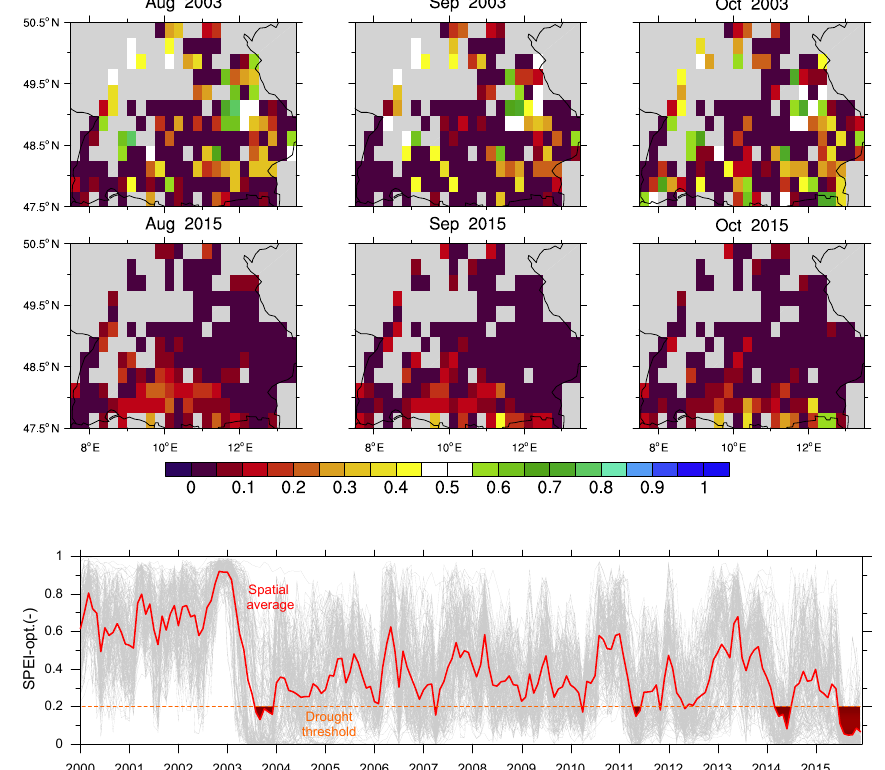
Figure 6. The reconstructed groundwater drought (SGI) based on the SPEI with spatially varying (optimal) accumulation periods during the months of August, September, and October for the 2003 and 2015 drought events over the south Germany study domain. The monthly time series of the optimally accumulated SPEI for every 0.25 ◦ grid cell and the respective spatial averages (dark red) are depicted in the bottom panel. The orange dashed line depicts the drought threshold ( τ ) of